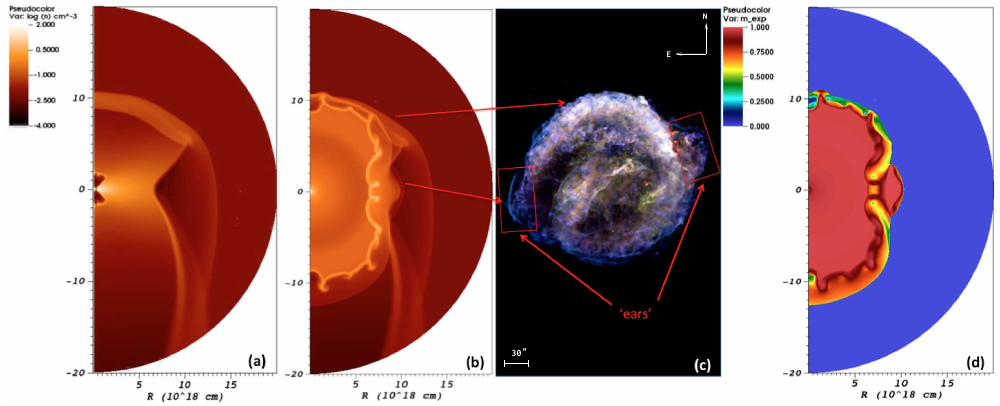
Figure 2. ( a ): the density distribution of the CSM that surrounds Kepler’s SNR at the moment of the explosion. ( b ) the density contours of the SNR after 420 yr of evolution. ( c ) The X-ray image of Kepler’s SNR [25]. ( d ) the expansion parameter of the SNR at t = 420